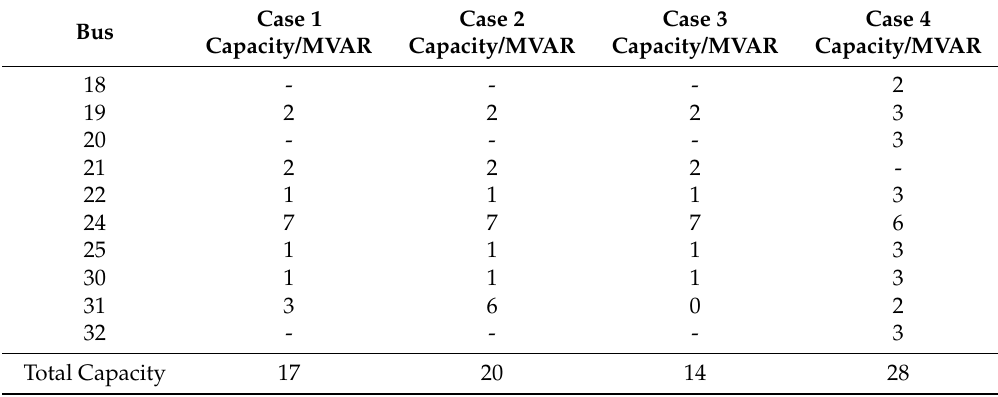
Table 3. Results of four reactive power planning (RPP)